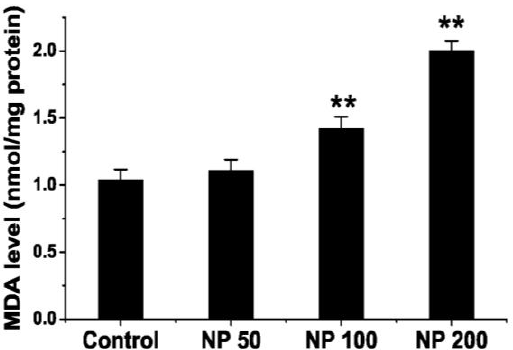
Figure 5. The effect of NP on malondialdehyde (MDA) level in mouse brain ( n = 9). Values are expressed as mean ± S.E.M. ** p < 0.01 vs. the vehicle